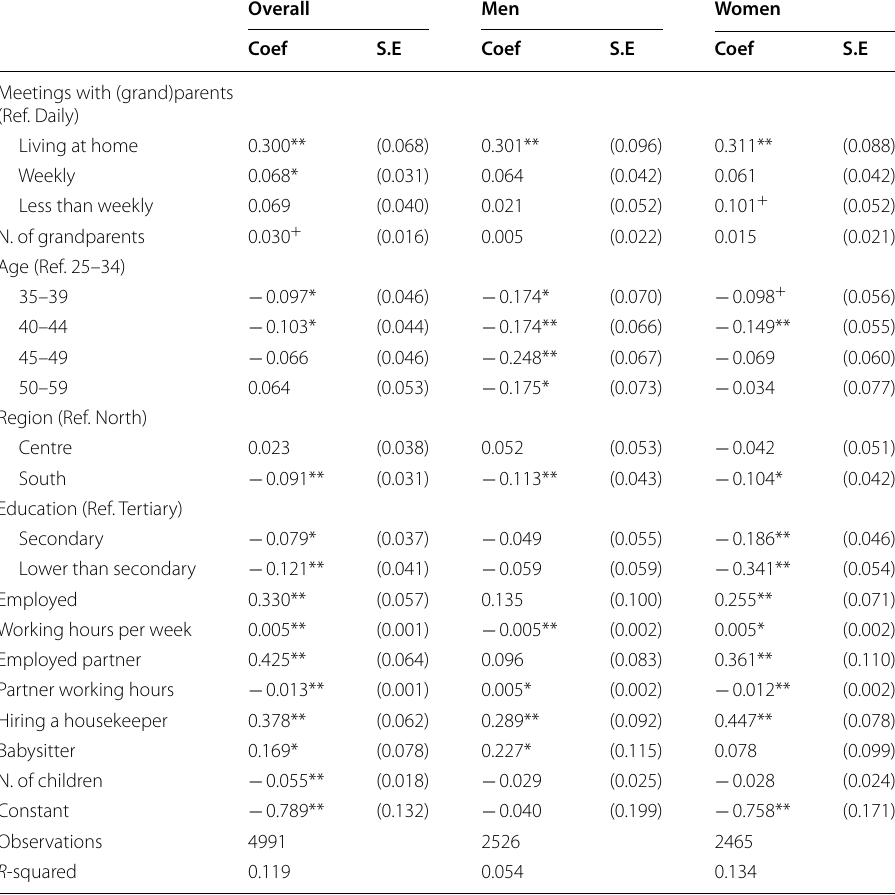
Table 3 Linear regression models on symmetry in the division of routine and instrumental housework tasks (5 items) ( Z